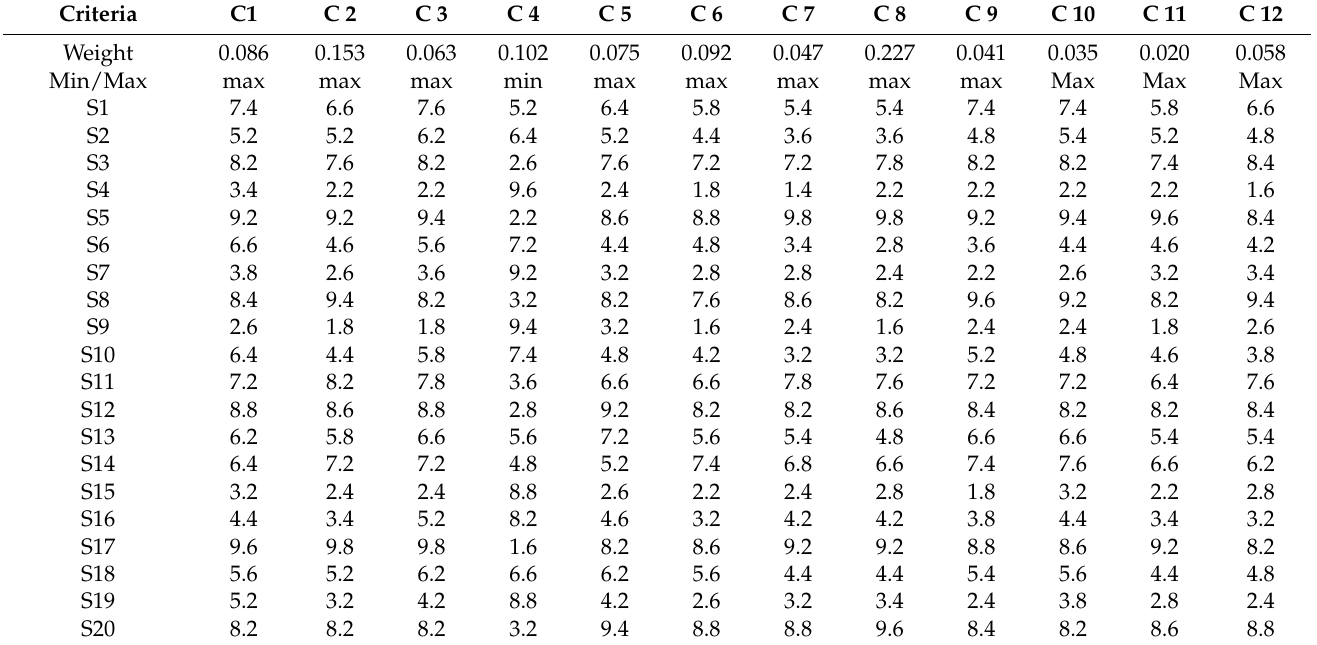
Table 9. Decision